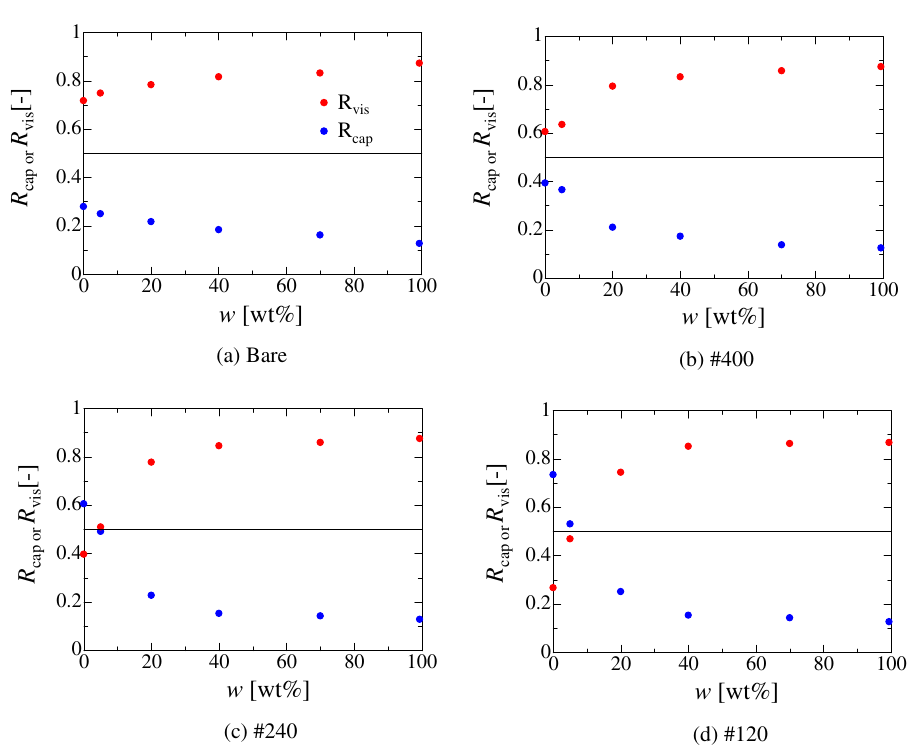
Figure 7. Liquid mass-concentration dependency on the non-dimensional energies of capillary ( R cap ) and viscous dissipation ( R vis ) for each solid substrate under the splashing condition. R cap and R vis are evaluated by ( E sprd + E def + E additional )/( E kine + E surf + E grav ) and E vis /( E kine + E surf + E grav ), respectively. Additional term E additional that is related to the adsorption energy ( E ads ) and the infiltration work ( E infil ) is included in R cap . The red and blue circles represent R vis and R cap , respectively. The black solid line represents R cap = R vis . R cap and R vis hold the relation of R cap + R vis =